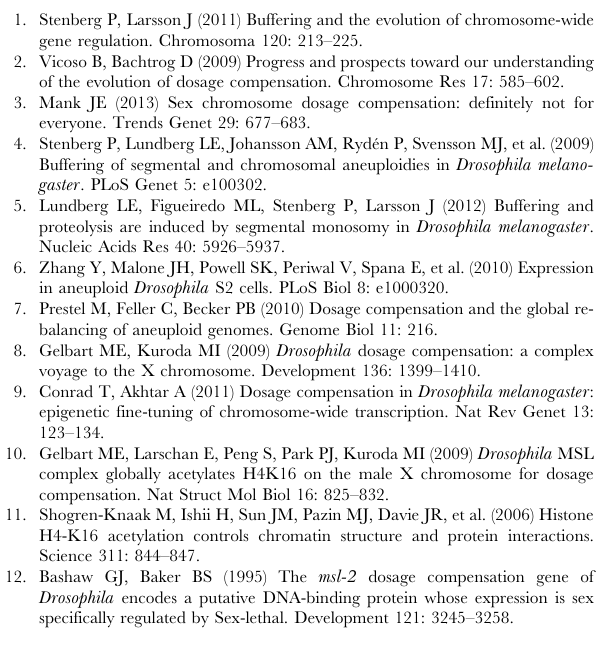
S2 Figure Female/male ratio of reads coverage from DNA-seq [50]. (A) Average for all genes of each chromosome. (B) Average for the six genes targeted by MSL in roX mutants, and for the remaining 4 th chromosome genes. (PDF) S3 Figure DNA-FISH with a probe against the mini- white gene (marker on pCas-attB-1360 ) combined with MSL2 immunostain- ing, on polytene chromosomes from roX mutant males carrying a transgene with the ankyrin cDNA downstream of three tandem repeats of 1360{}6073, identical to the Hoppel element. (PDF) S4 Figure MSL3 and HP1a immunostaining on polytene chromosomes from roX mutant males carrying a transgene with 256 tandem repeats of lacO gene and another transgene coding for the protein fusion HP1-lacI.BD, which is tethered to lacO ( roX1 ex6 Df(1)roX2 52 P[w + 4 D 4.3]/Y;P[Ecol\lacO.256x.w]157.4.112/ + ; P[hs-HP1.lacI.BD]/ + ). (PDF) S1 Table List of primer pair sequences used in the quantitative real-time PCR